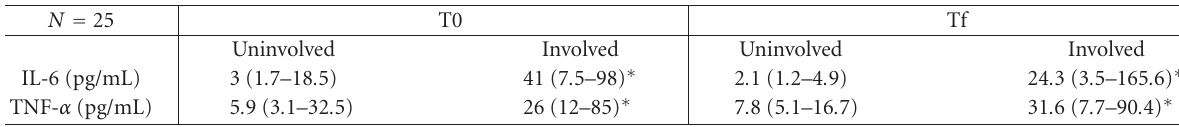
Table 3. Data on IL-6 and TNF- α levels in blister fluid in the involved and uninvolved extremities at first measurement (T0) and follow-up measurement (Tf). Data are presented as median ± interquartile range.